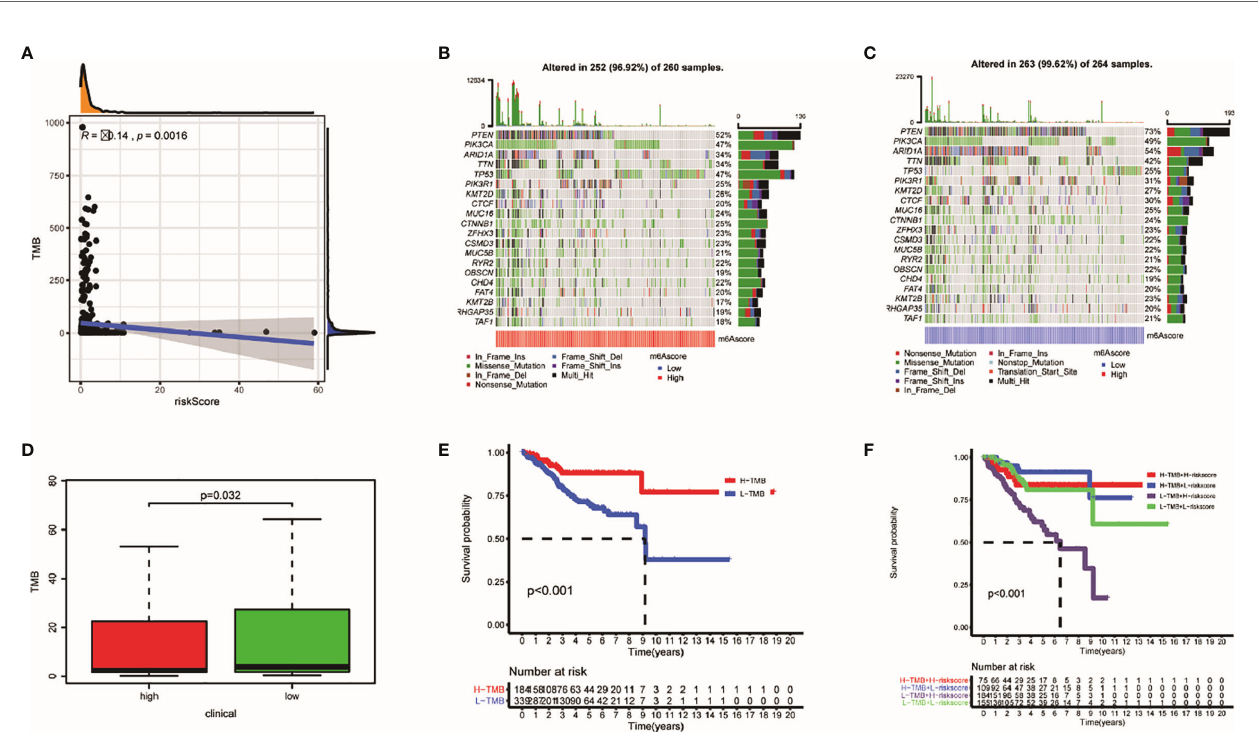
FIGURE 10 | The mutation pro fi le and TMB among low- and high-risk groups. (A) The relationship between TMB and TRRS. (B, C) Mutation pro fi le of low- and high-risk groups. (D) The relationship between the TRRS and TMB. (E, F) The association of TMB and prognosis in TCGA UCEC